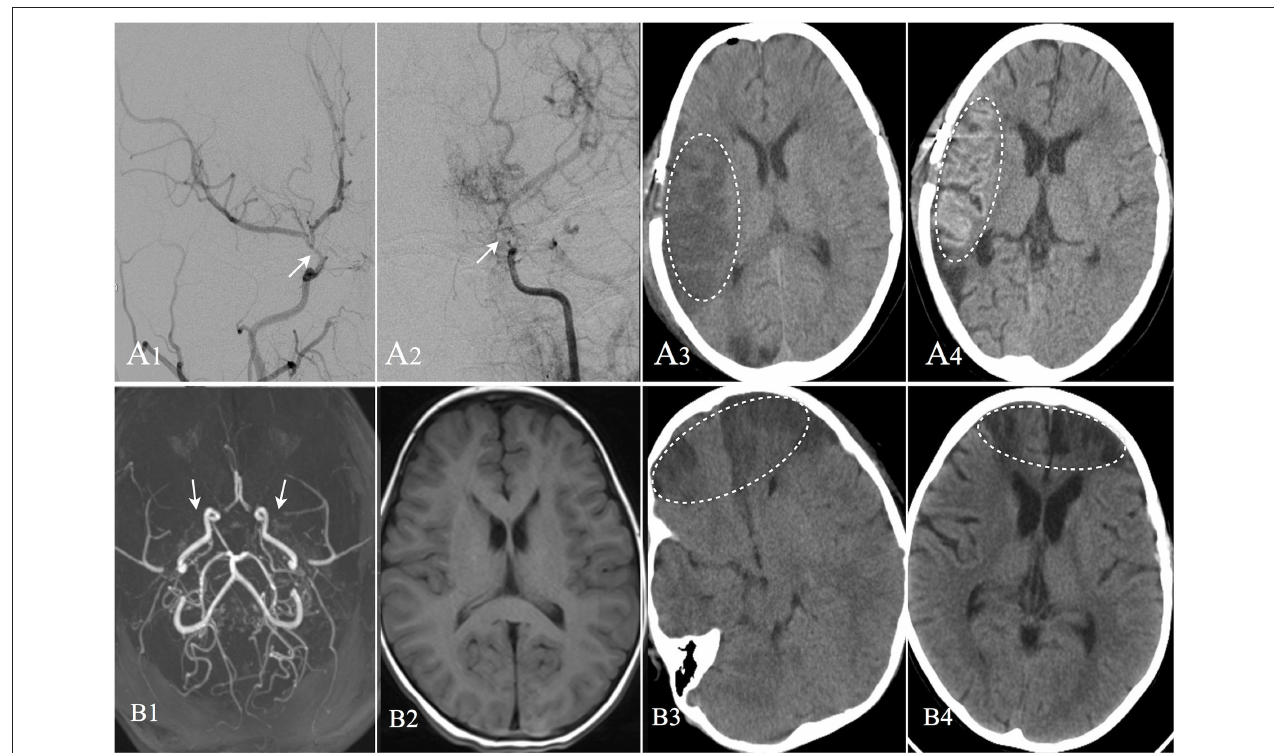
FIGURE 3 | Two cases suffered postoperative operate-related infarction were showed. Patient A: 8 years old male, DSA confirmed moyamoya disease (A1,A2) . CT image showed cerebral infarction occurred in the right operative region at the second day after EDAS operation (A3) . CT performed at the 13th day after operation showed the infarction region with cortical laminar necrosis (A4) . The patient was discharged with weakness in his left limbs; Patient B: 4 years old female, MRA confirmed moyamoya disease (B1) . MRI image showed no remote cerebral infarction (B2) . CT image showed cerebral infarction occurred in bilateral frontal lobes at the second day after EDAS operation (B3) . CT performed at the 20th day after operation showed improvement in the infarction region (B4) , and the patient was discharged with weakness in her upper right